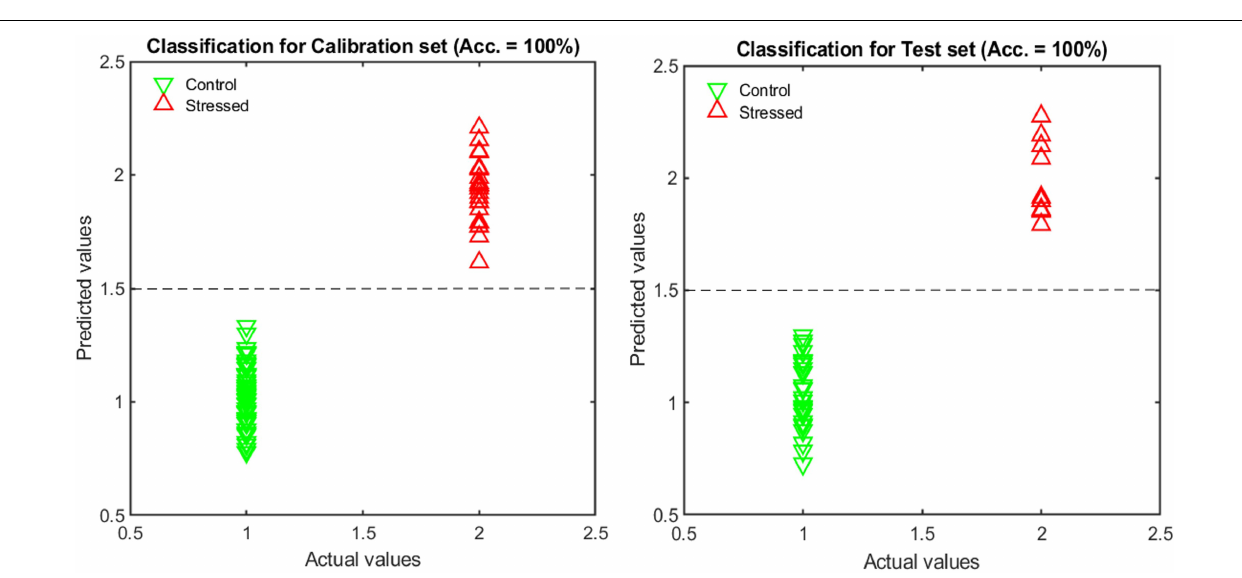
FIGURE 6 | Classification results for normal and stressed plants using three images.